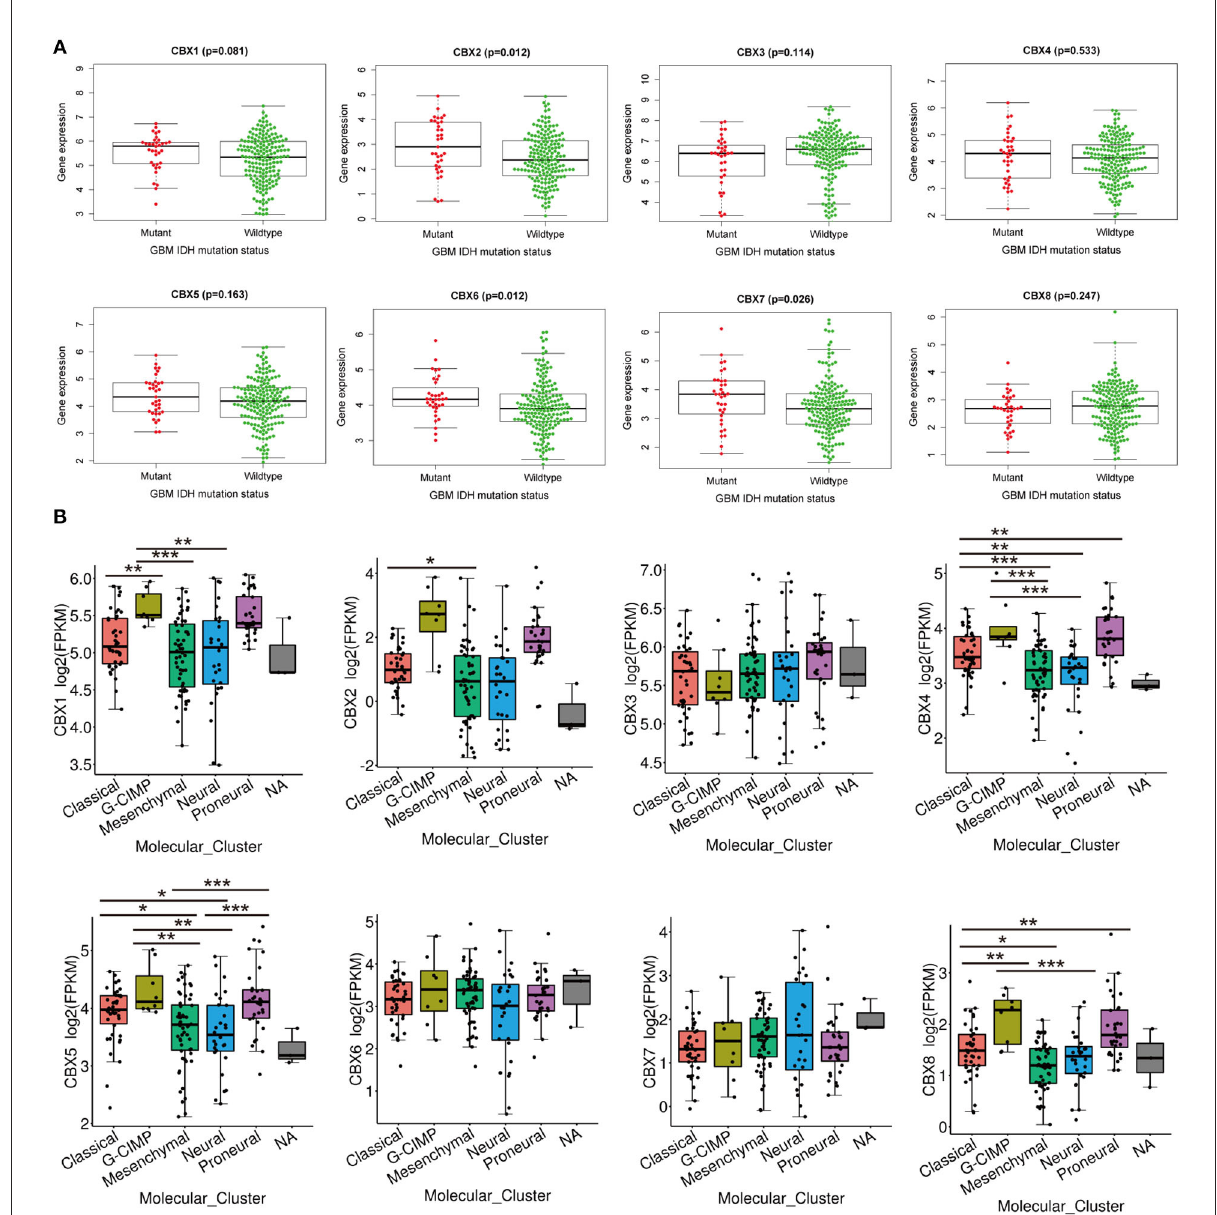
FIGURE4 IDH mutation and molecular GBM subtypes were correlated with the mRNA expression of CBX family. (A) The difference in the mRNA expression of CBX family between IDH mutation (Red) and wildtype (Green) groups was explored in CGGA database by “survminer” R package. The p -value was set at 0.05. (B) Molecular subtypes in GBM, including Classical, Proneural, Neural, Classical, and Mesenchymal subtypes, were explored in differential mRNA expressions of CBX family by TCGA portal. (* p < 0.05, ** p < 0.01, *** p < 0.001).